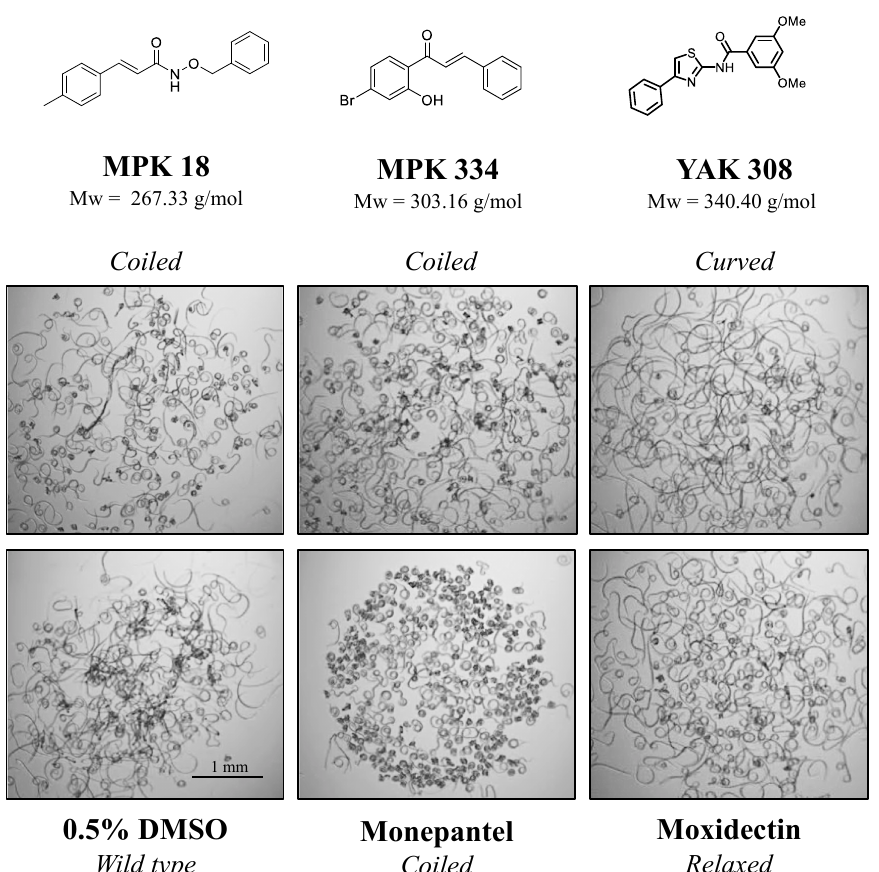
Figure 1. Three compounds identified to induce abnormal phenotypes in exsheathed third-stage larvae (xL3) of Haemonchus contortus in the primary screen. The representative single-frame images (25-times magnification) of short video (5 s) of xL3s captured in primary screen displaying non-wildtype phenotypes (“coiled” or “curved”) induced by each of the three hit compounds (MPK18, MPK334 and YAK304) at 20 µM after 72 h of exposure. The structures of three compounds are presented with their respective molecular mass (Mw). Two control compounds (monepantel and moxidectin) at 20 µM, and no compound control (0.5% DMSO), were used as references to the non-wildtype (“coiled” for monepantel) and wild-type phenotypes, respectively. MPK18- and MPK334-treated xL3s exhibited a “coiled” phenotype, similar to xL3s exposed to that of monepantel. YAK304-treated xL3 showed a “curved” phenotype, which was distinct from all controls.